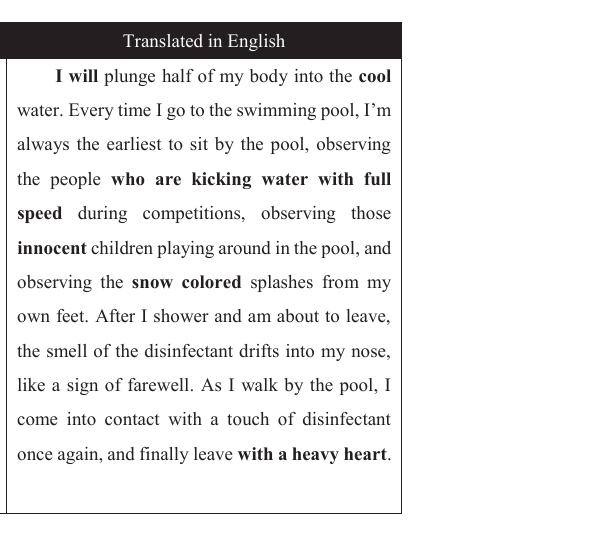
sentence structures for fluent expression; (4) Chinese